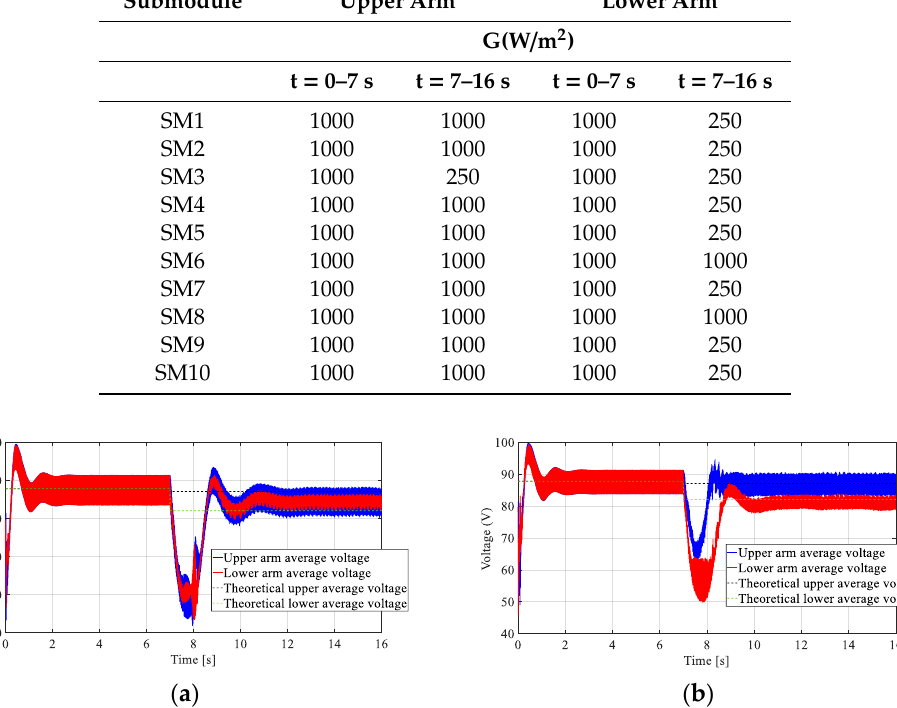
Figure 8. Average arm voltages: ( a ) CMPPT control; ( b ) DMPPT control.